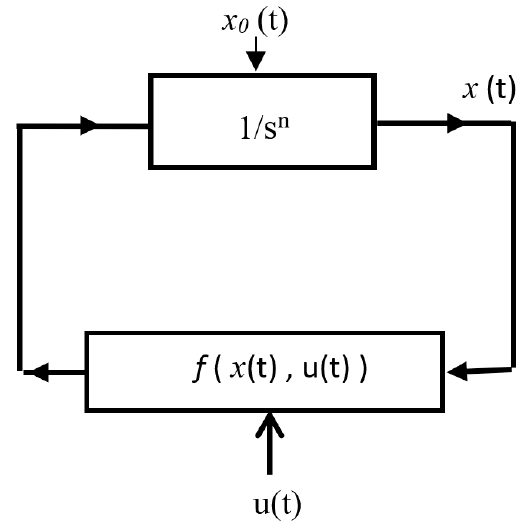
Figure 3. Closed-loop model of the FDE/FDS.